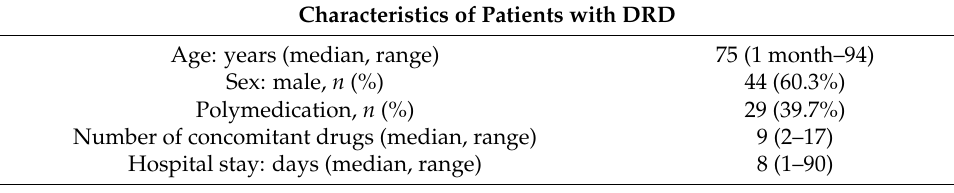
Table 1. Characteristics of patients with